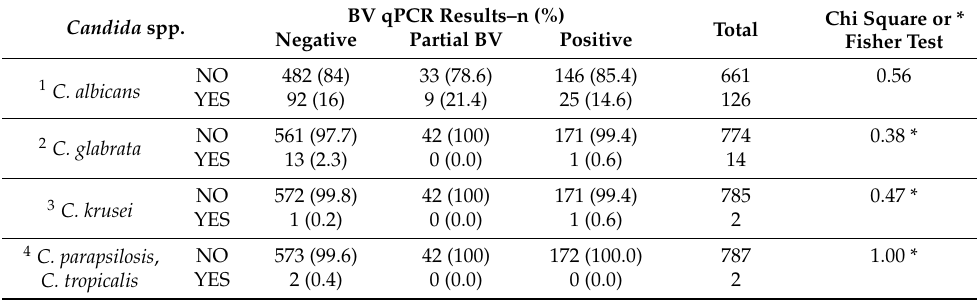
Table 4. Association between a specific Candida species and the presence of bacterial vaginosis. Candida spp.